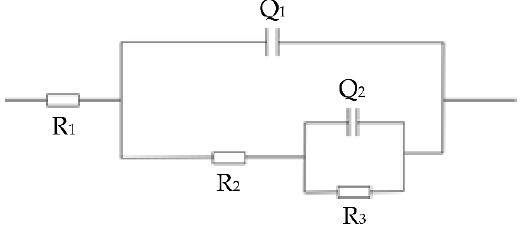
Figure 8. Equivalent circuit diagram of grade 45 steel Ni35 + 20% SiC and Ni35 + 20% SiC + 20% Ni/MoS 2 cladding in 3.5%NaCl solution. Table 4. Equivalent circuit diagram fitting data table.